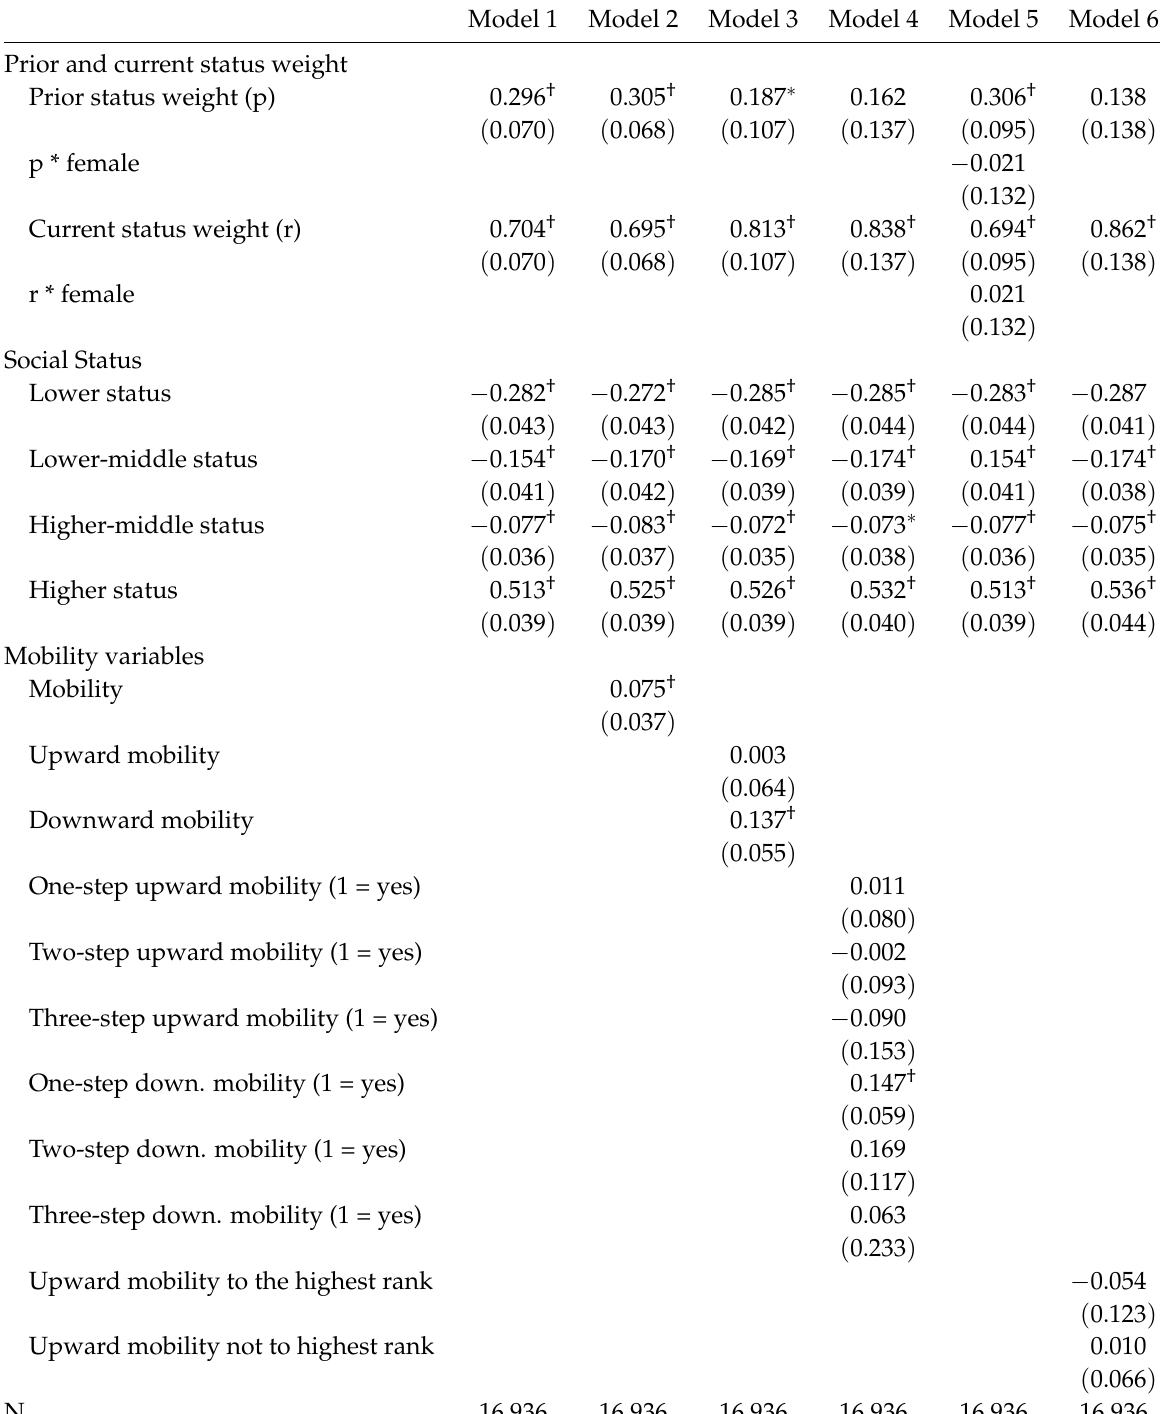
Table 4: Intragenerational estimates from diagonal mobility models predicting